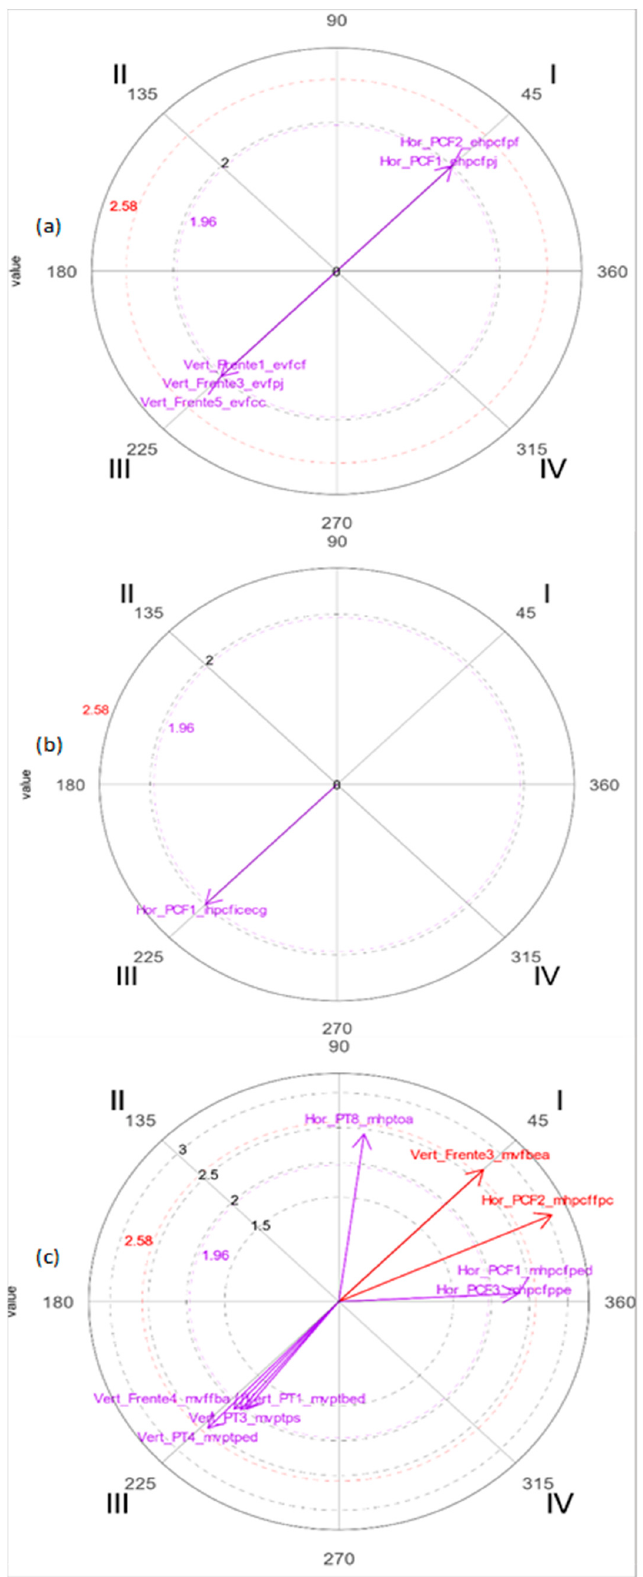
Figure 3. Polar coordinate maps of the character with the highest number of significant vectors in the representation of movement in the drawings at 7 years. ( a ) Macrocategory static -wolf; ( b ) macrocategory indication -rabbit; ( c ) macrocategory movement -rabbit.